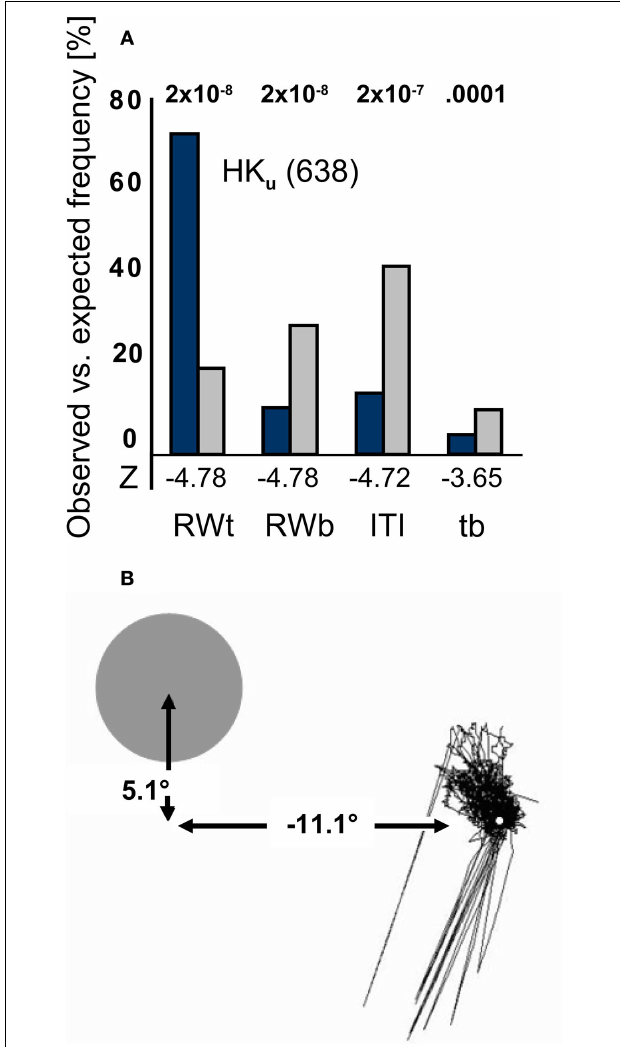
FIGURE 5 | Mean observed vs. expected response frequency and fi xation for HK . (A) HK ’s responses occurred signifi cantly more often than expected u u by chance in the target response windows, and signifi cantly less often in all other event type time windows. The fi rst P -value is the same for target and blank stimulus response windows. Notation as in Figure 4 . (B) Eye movements recorded over a typical block of 120 trials in the un-cued condition are shown in relation to the stimulus position in the upper quadrant. Lines toward the lower left refl ect